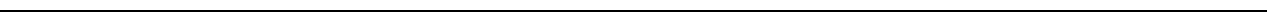
Fig. 6 Cell cycle markers misrepresent proliferation after AKI because numerous TEC endocycle. a – c Ki-67 + (blue) Phalloidin + (purple) tubules at day 0 ( a ), 2 ( b ) and 30 after IRI ( c ) ( n = 3 per group). d Percentage of Ki-67 + cells over Phalloidin + TECs at T0, IRI T2, and IRI T30 ( n = 3 per group). e – g PCNA + cells at T0 ( e ), IRI T2 ( f ), and IRI T30 ( g ) ( n = 5 per group). h Percentage of PCNA + cells over TECs at T0, IRI T2, and IRI T30 ( n = 5 per group). i – k mCherry + cells (red) and mVenus + cells (green) in Pax8/FUCCI2 mice at T0 ( i ), IRI T2 ( j ), and IRI T30 ( k ) ( n = 4 per group). Phalloidin staining is white. l Percentage of mCherry + cells, mVenus + cells and mCherry + mVenus + cells in Pax8/FUCCI2 mice at T0, IRI T2, and IRI T30. ( n = 4 per group). m – o mCherry + cells (red) and mVenus + cells (green) in Pax2/FUCCI2 mice at T0 ( m ), IRI T2 ( n ) and IRI T30 ( o ) ( n = 4 per group). Phalloidin staining is white. p Percentage of mCherry + cells, mVenus + cells and mCherry + mVenus + cells in Pax2/FUCCI2 mice at T0, IRI T2, and IRI T30. ( n = 4 per group). q , r mCherry + cells (red), mVenus + cells (green) and p-H3 + cells (blue) in Pax8/FUCCI2 mice at IRI T2 ( q ) and IRI T30 ( r ) ( n = 4 per group). q ′ , r ′ Details indicated by arrowheads and asterisks in q and r . s Percentage of p-H3 + mCherry + cells and p-H3 + mVenus + cells in Pax8/FUCCI2 mice at IRI T2 and IRI T30. ( n = 4 per group). t , u mCherry + cells (red), mVenus + cells (green) and p-H3 + cells (blue) in Pax2/FUCCI2 mice at IRI T2 ( t ) and IRI T30 ( u ) ( n = 4 per group). t ′ , u ′ Details indicated by arrowheads in t and u . v Percentage of p-H3 + mCherry + cells and p-H3 + mVenus + cells in Pax2/FUCCI2 mice at IRI T2 and IRI T30. ( n = 4 per group). w , x Cell cycle distribution of mCherry + , mVenus + , and mCherry + mVenus + cells in Pax8/FUCCI2 mice ( w ) and Pax2/FUCCI2 mice ( x ) at IRI T2 ( n = 4, left) and at IRI T30 ( n = 5, right). Representative experiments are shown. y , z Percentage of cells over total Pax8/FUCCI2 cells ( y ) and over total Pax2/FUCCI2 cells ( z ) at IRI T2 ( n = 4) and IRI T30 ( n = 5). Data are mean ± SEM. Scale bars 20 µ m. DAPI (white) counterstains nuclei. T0 = day 0, IRI T2 = day 2 after IRI, IRI T30 = day 30 after